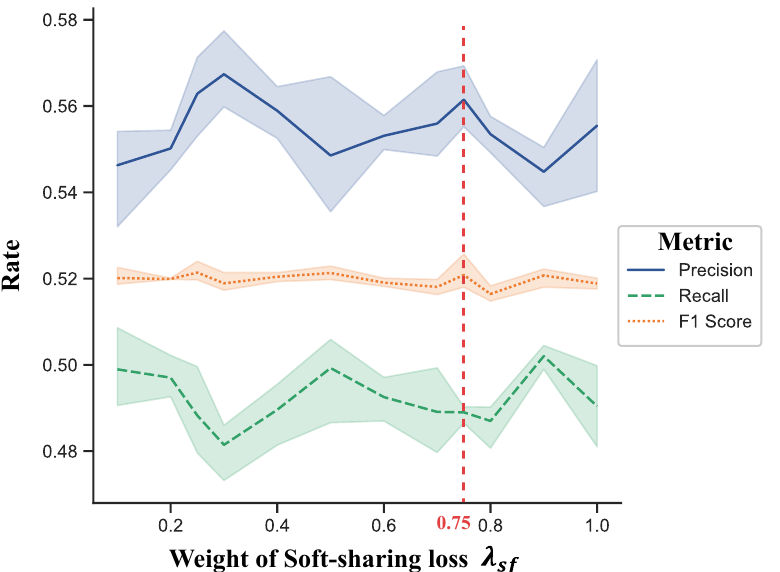
Figure 4. Repeated experiments on the determination of the value of λ sf in different metric. A higher percentage value and a smaller variance indicate better results. It is not appropriate to use weights that are too high or too low.